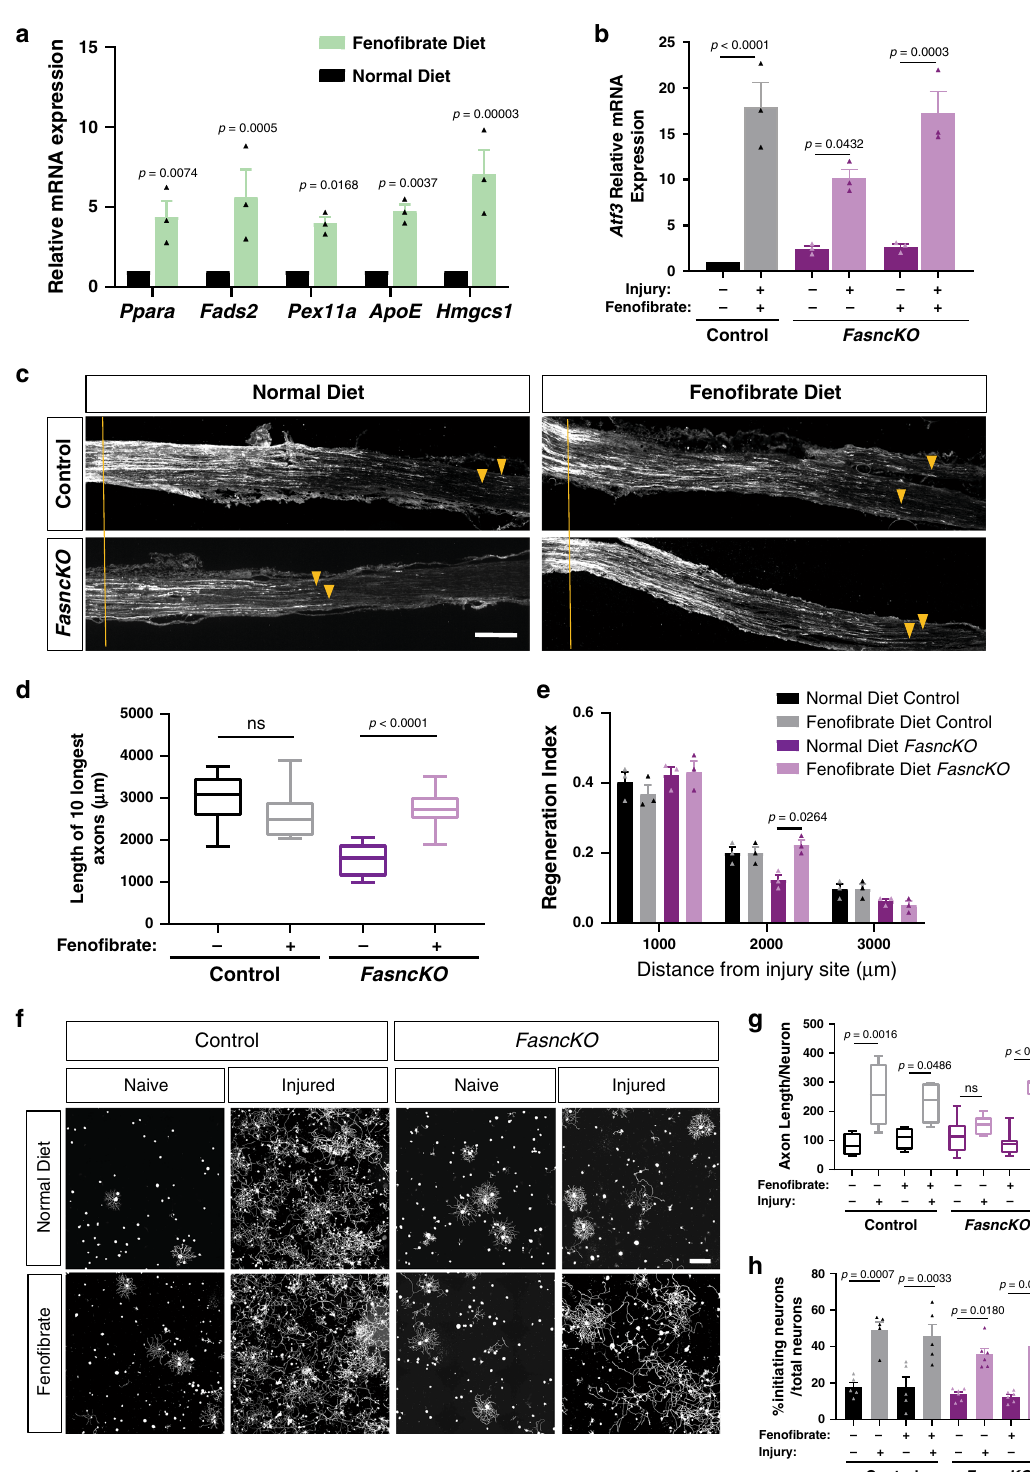
macrophages in fi ltrating between neuron and SGC 77 were mis- identi fi ed as proliferating SGC. Our analysis revealed that SGC activate PPAR α signaling to promote axon regeneration in adult peripheral nerves. PPARs are ligand-activated nuclear receptors with the unique ability to bind lipid signaling molecules and transduce the appropriate signals derived from the metabolic environment to control gene expression 25 . Accordingly, PPARs are key regulators of lipid